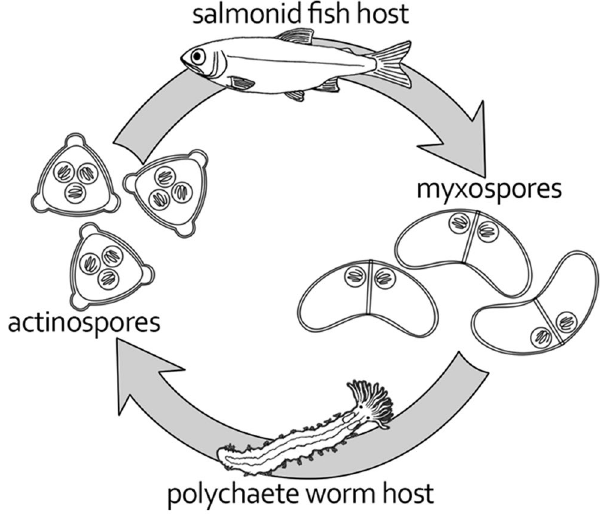
Figure 1. Life cycle of Ceratonova shasta showing alternation between salmonid fish and polychaete worm hosts, infected by actinospore or myxospore, respectively. Myxospores have two polar capsules, and actinospores have